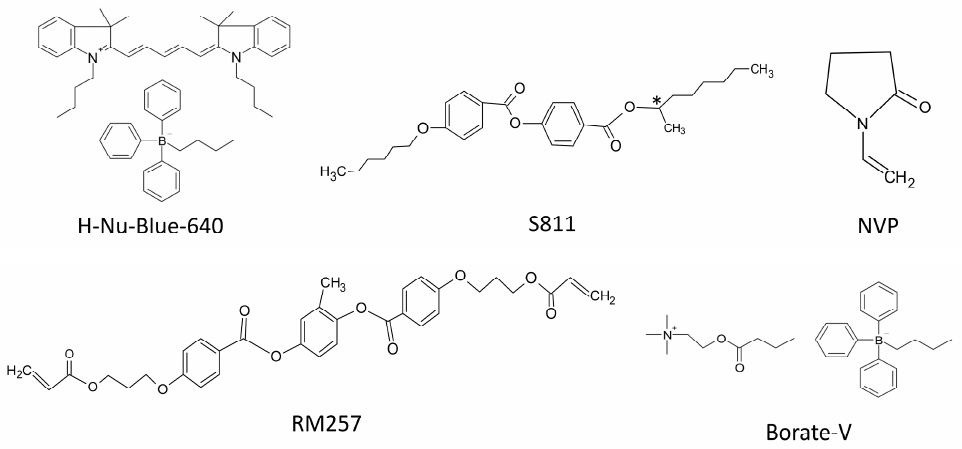
Figure 1. Chemical structures of all ingredients in the prepared liquid crystal (LC) mixture except for nematic LCs. Table 1. Experimental cells with various ratios of ingredients in LC mixtures for processing holographic exposure.